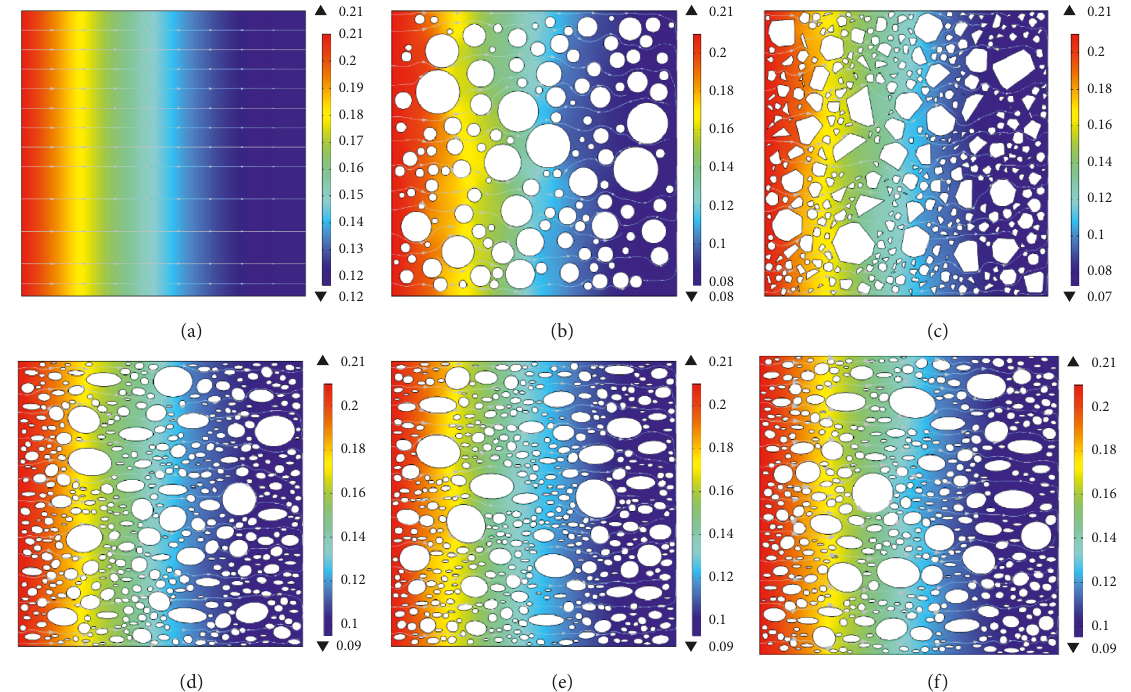
Figure 13: Chloride ions concentration distribution and streamline. (a) Mortar; (b) circle; (c) convex polygon; (d) mixed circle and ellipse; (e) mixed circle and ellipse; (f) mixed circle and